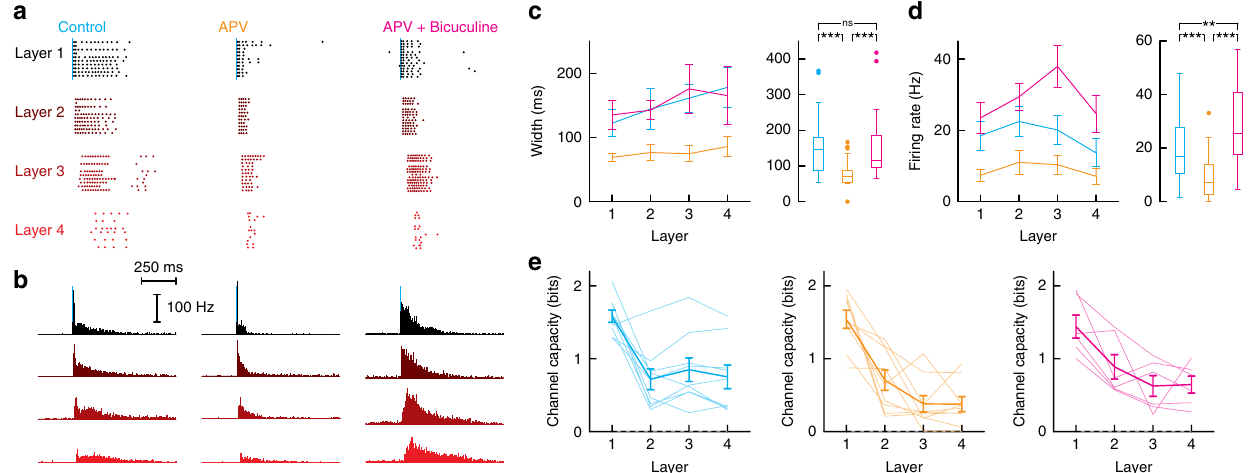
Fig. 7 Roles of AMPA and NMDA-mediated components in the propagation of activity. a Example of dot rasters of spikes recorded from individual neurons in each layer (layers 1 – 4 from black to red) in cell-attached mode in response to synchronized activation of neurons in the fi rst layer (30 repetitions) under control conditions (left), in the presence of 50 µ M APV, and in the presence of APV and 10 µ M bicuculline (right). b Average poststimulus time histogram in each layer. Data were compiled from 9 networks of density = 278 ± 68 neurons·mm − 2 (mean ± STD). c Left, average fi ring rate half width vs layer (mean ± SEM). Right, data combined across layers shown as whisker plots (box: median and interquartile range, whiskers: full range of the distribution; outliers are plotted individually). d Similar plots for the fi ring rate. Mann – Whitney U -test statistics for the width: control vs APV: P = 7.5 × 10 − 6 , APV vs Bicuculine: P = 2.7 × 10 − 6 , control vs Bicuculine: P = 0.85. Mann – Whitney U -test statistics for the fi ring rate: control vs APV: P = 3.2 × 10 − 4 , APV vs Bicuculine: P = 1.1 × 10 − 7 , control vs Bicuculine: P = 0.008. ns not signi fi cant, * P < 0.05, ** P < 0.01, *** P < 0.001. e Channel capacity quanti fi ed as the probability of correctly classifying fi ring rate in the fi rst layer given the fi ring rate in the n th layer. All data are shown and the mean ± SEM is represented as thick lines. Mann – Whitney U -test statistic for the comparison of decoding accuracy of neurons in layers 2 – 4 vs conditions: control vs APV: P = 0.010, APV vs Bicuculine: P = 0.032, control vs Bicuculine: P =